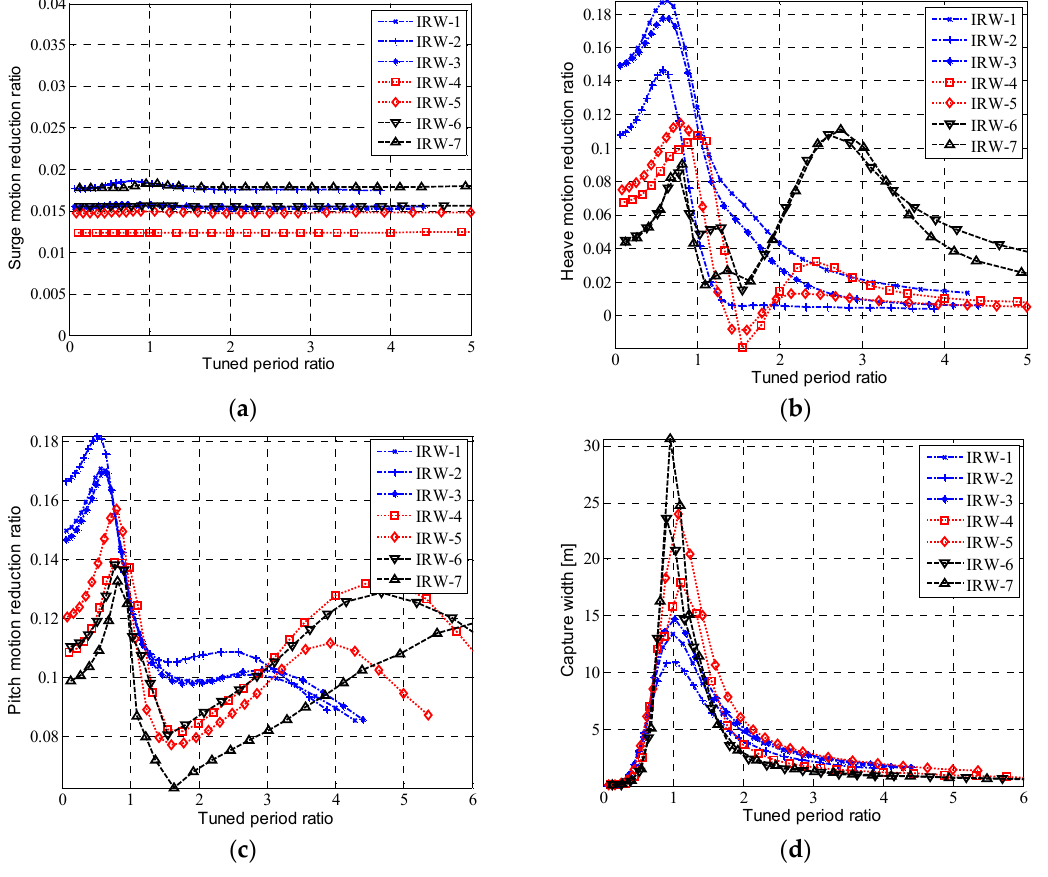
Figure 14. ( a ) The surge motion reduction ratio with the tuned period ratio under different wave conditions with ξ PTO “ 0.1; ( b ) the heave motion reduction ratio with the tuned period ratio